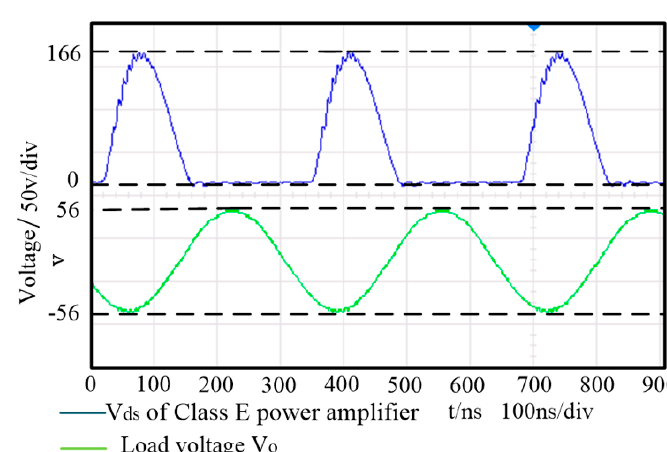
Figure 12. Experimental set up.